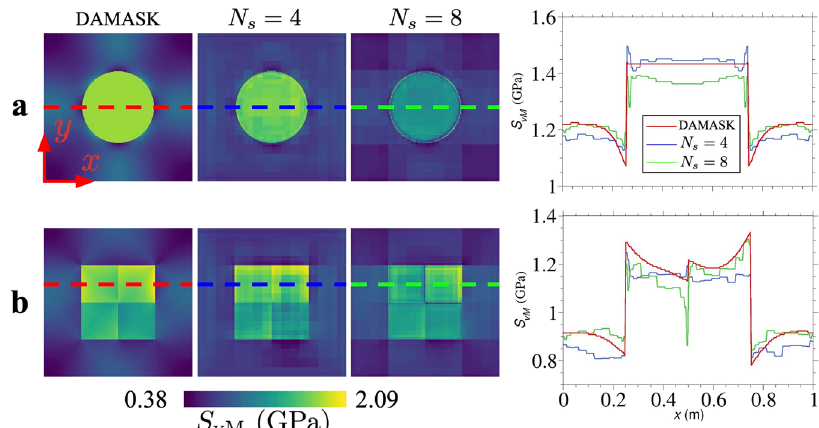
Fig. 4 Effect of network depth on predicted stress distribution. Von Mises stress distribution around circular ( a ) and square ( b ) inclusions calculated by DAMASK as well as two network architectures with depths of N s = 4 and N s = 8. The stress pro fi les are plotted along the dashed lines with red, blue and green corresponding to DAMASK, network with N s = 4 and N s = 8 based results,